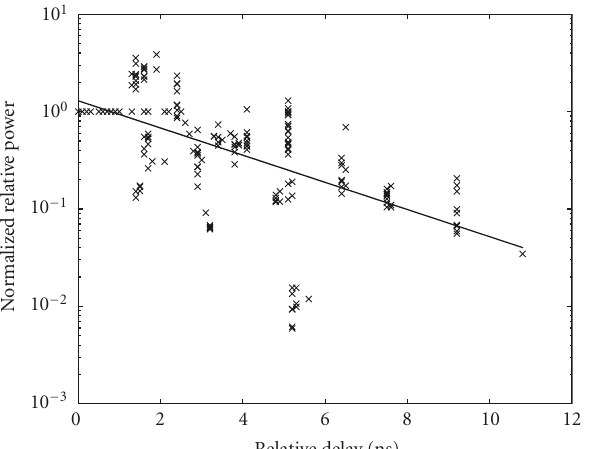
Figure 25: Normalized cluster power decay for measurements from the Escalade engine compartment.